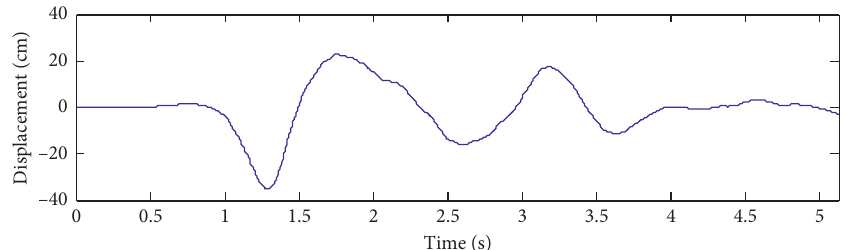
Figure 3: Displacement of El Centro wave.